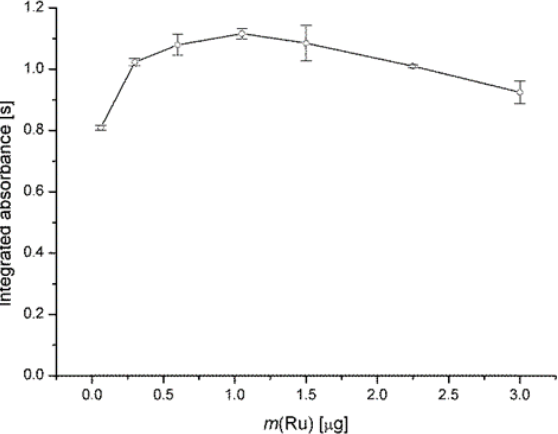
Figure 3. Dependence of GaF molecule absorbance at 211.248 nm on the mass of ruthenium in the modifier solution; T pyrol. = 600 °C; T vapor. = 1540 °C; m (Pd) = 7.5 μ g; m (Zr) = 0.15 μ g; C (Ga pretr. ) = 50 μ g; m (Ga sol. ) = 20 μ g; m (CH 3 COONa) = 5.0 μ g.